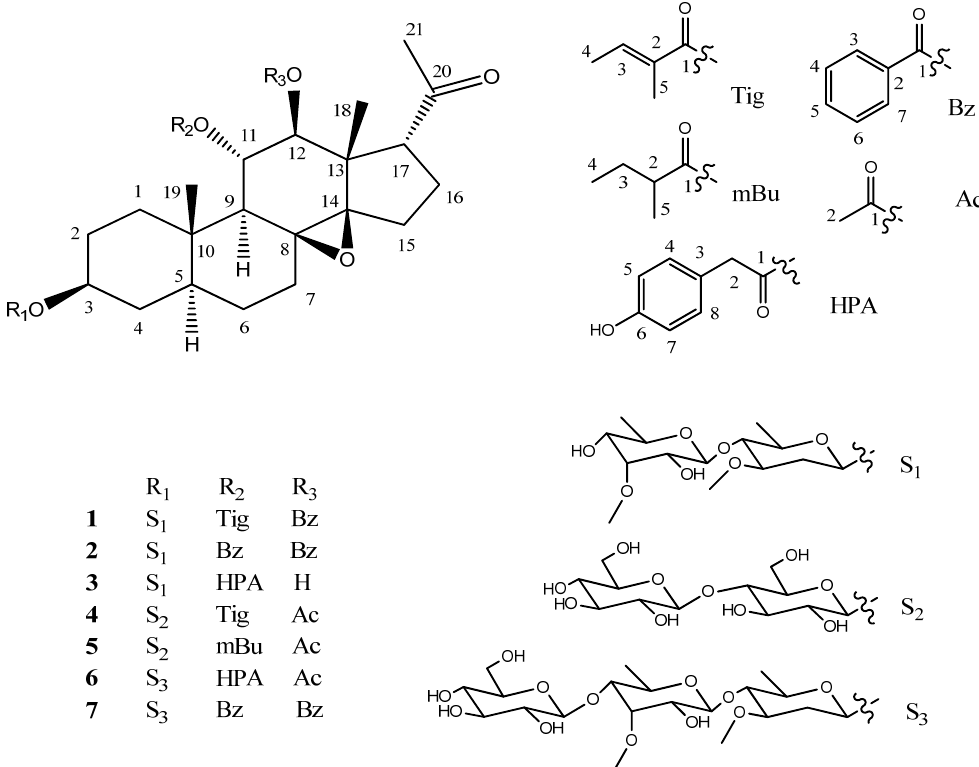
Figure 1. Structures of pregnane glycosides ( 1 – 7 ) isolated from M . tenacissima